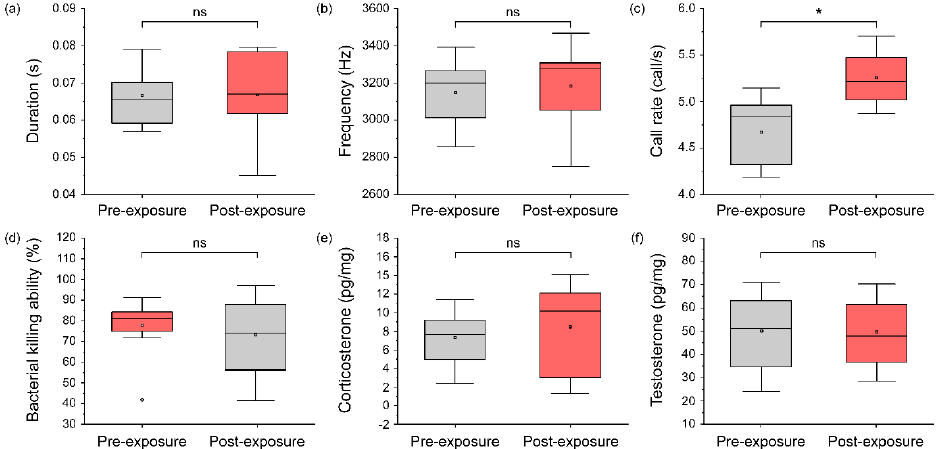
Figure 6. The change in calling pattern, immunity, and physiological conditions due to exposure to wind turbine noise: ( a ) note duration, ( b ) dominant frequency, ( c ) call rate, ( d ) bacterial killing ability, ( e ) corticosterone, and ( f ) testosterone. The gray boxes represent pre-exposure conditions, and the red boxes represent post-exposure conditions. Significant differences ( p < 0.05) were determined using a paired t -test (and Wilcoxon rank – sum test in immunity graph) and are represented by asterisks (*). Table 3. Analysis of behavioral (note duration, dominant frequency, and call rate); physiological (testosterone, T); and immunological (bacterial killing ability, BKA) factors that significantly interact with corticosterone (CORT) determined using multiple linear regression analysis. Call rate and BKA represents significant correlation ( p < 0.05) with the